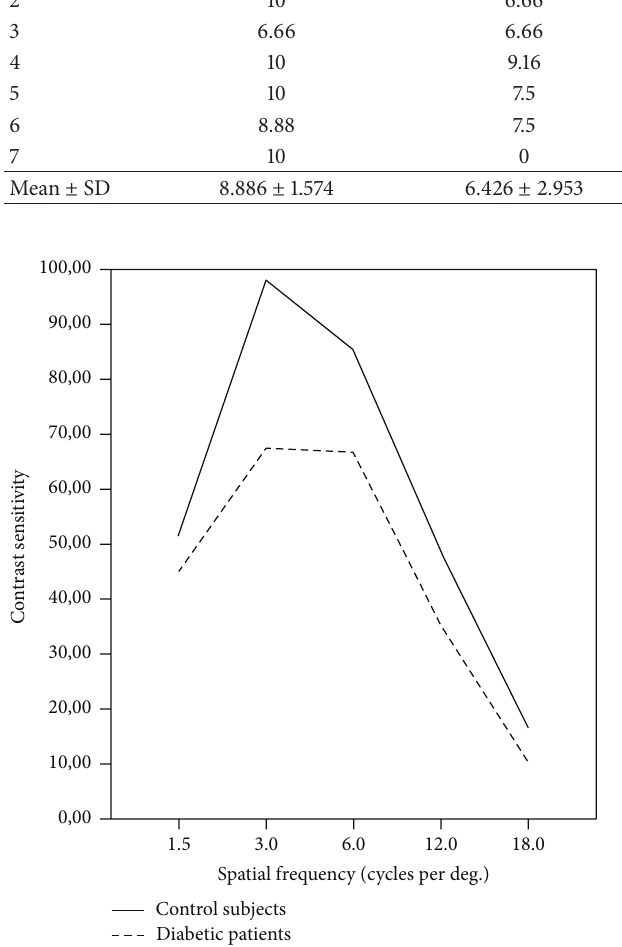
Figure 2: Contrast sensitivity function between control subjects with(dashed/dottedline)andwithout(solidline)riskofundergoing diabetes